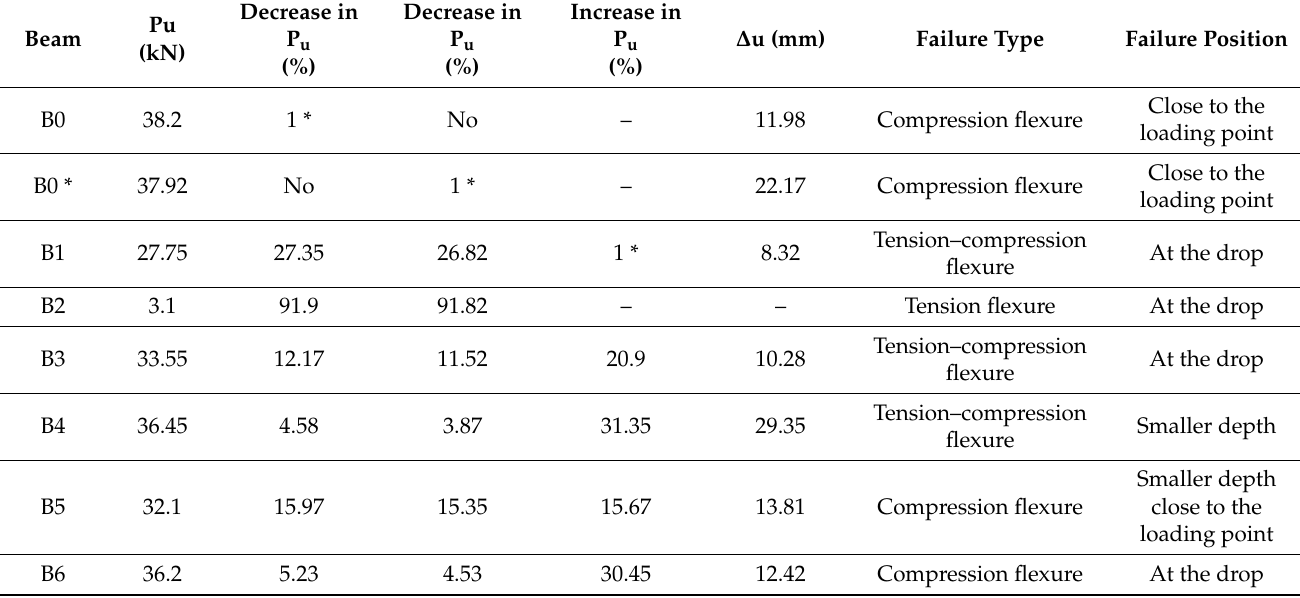
Table 2. Results of the tested beams of group G1.